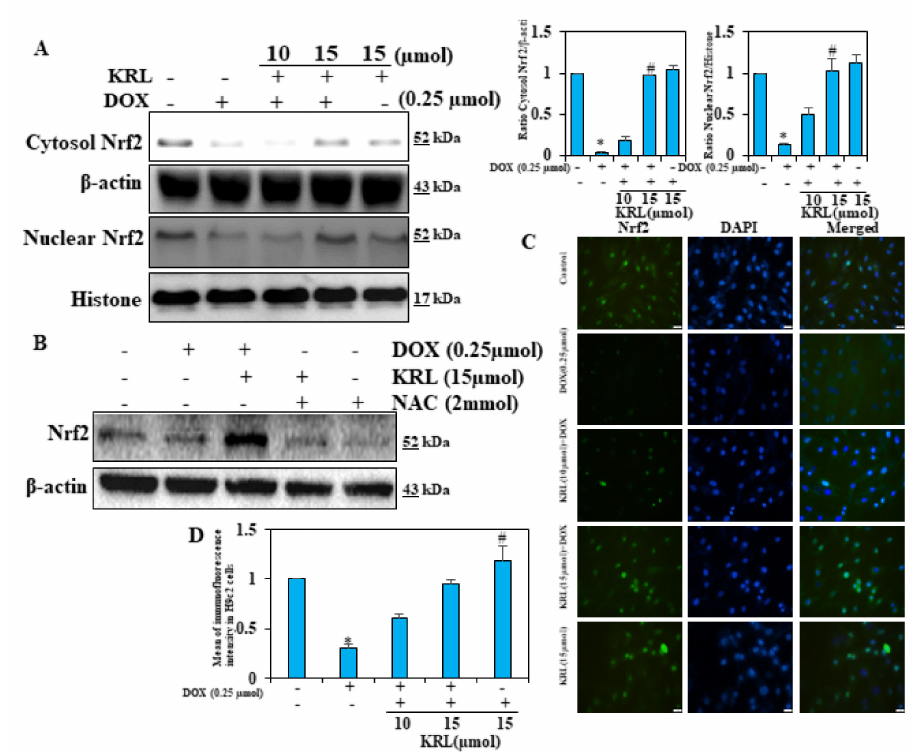
Figure 5. KRL enhances NRf2 translocation in DOX-treated H9c2 cells. ( A ) Changes in Nrf2 levels were determined in nuclear and cytosolic fractions of cells. Relative changes in protein intensities were quantified using Image Studio Lite software and presented as a histogram, with the control set at one-fold. ( B ) Cells subjected to reactive oxygen species (ROS) inhibitor treatment (1mM NAC for 60min) before KRL treatment for 24 h. The expression of total Nrf2 was analyzed by Western blotting. ( C ) Cells were pre-treated with KRL (15 µ mol) for 2 h and then stimulated with or without DOX (0.25 µ mol) for 24 h. Immunofluorescence staining was performed to detect the nuclear localization of Nrf2. Following incubation with primary antibody (anti-Nrf2) and conjugated secondary antibody, cells were stained with DAPI (1 µ g/mL) for 5 min. The subcellular localization of Nrf2 in all conditions was visualized under fluorescence microscopy. Scale bar indicated 100 µ m at 20 × magnification. ( D ) Indicated Nrf2 immunofluorescence intensity levels of Control and treated H9c2 cells. Data are represented as the mean ± SD of triplicate values ( n = 3) and * p < 0.05 represents significant variations compared with the control. # p < 0.05 represents significant variations as compared to DOX alone and KRL with DOX treatment